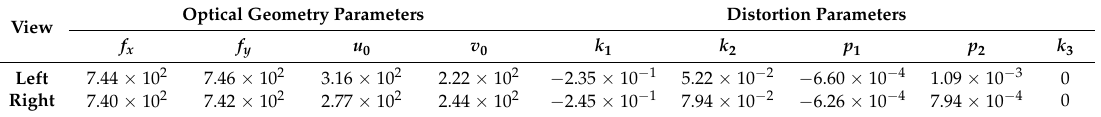
Table 1. Intrinsic parameters of the binocular vision system (in water, at 1 m distance). View